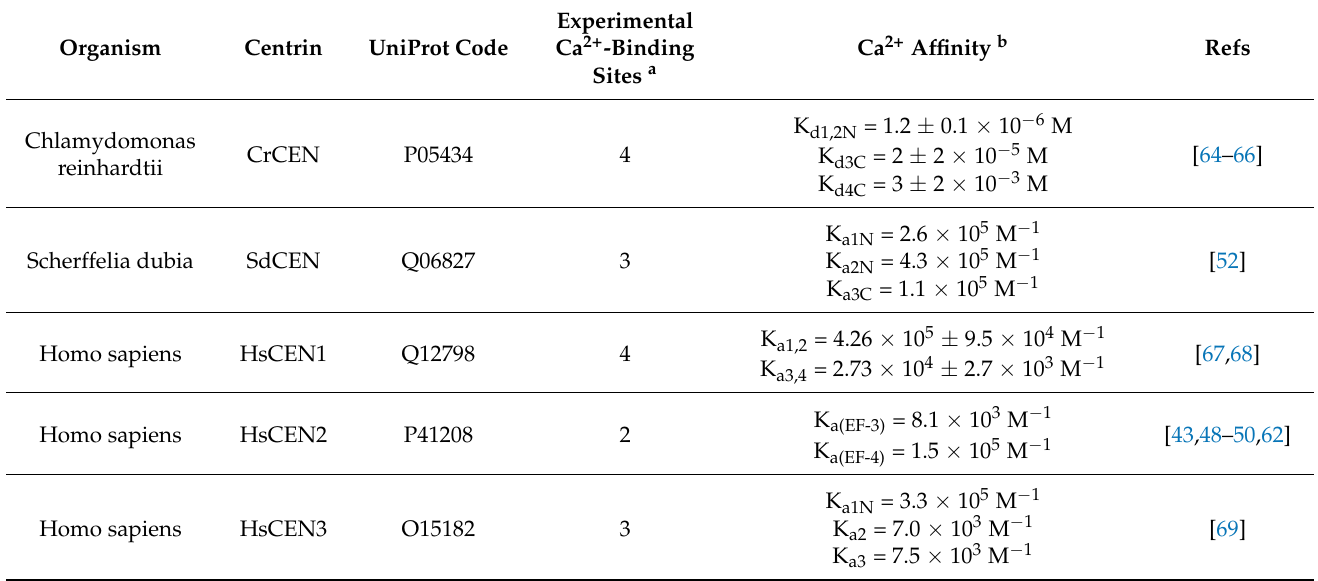
Table 1. Ca 2+ binding properties of